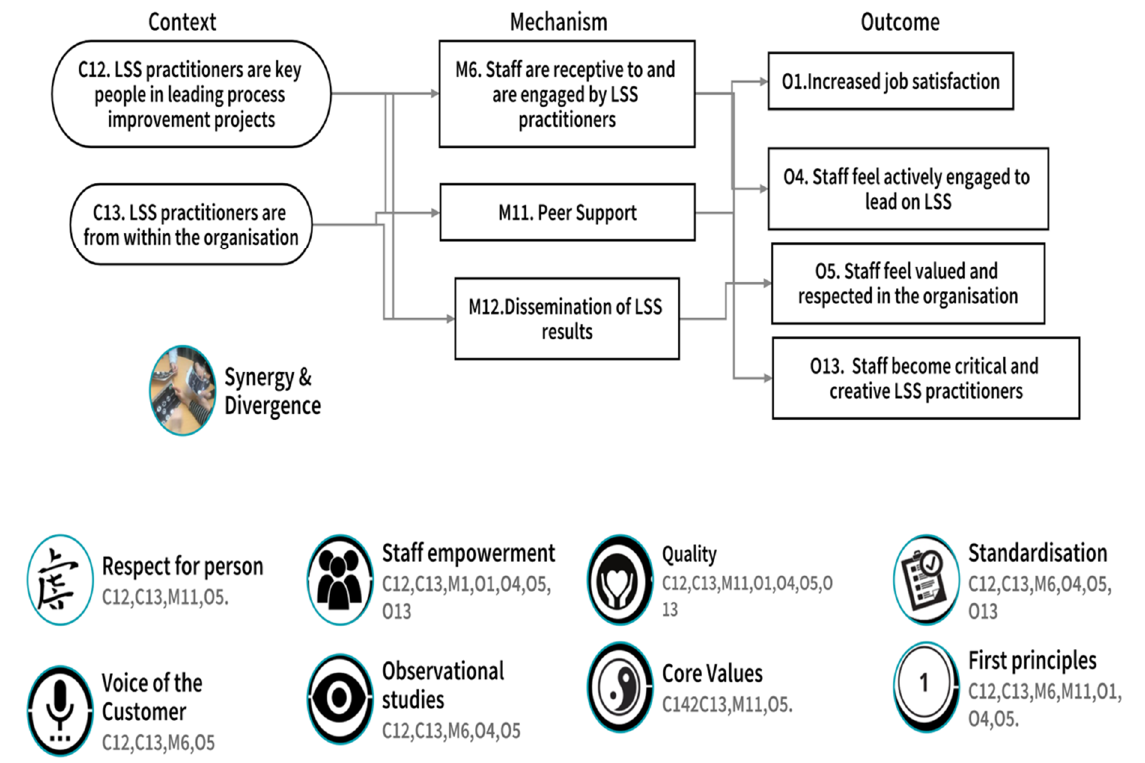
Figure 7. CMOc3 participants’ self-perception as LSS practitioners.